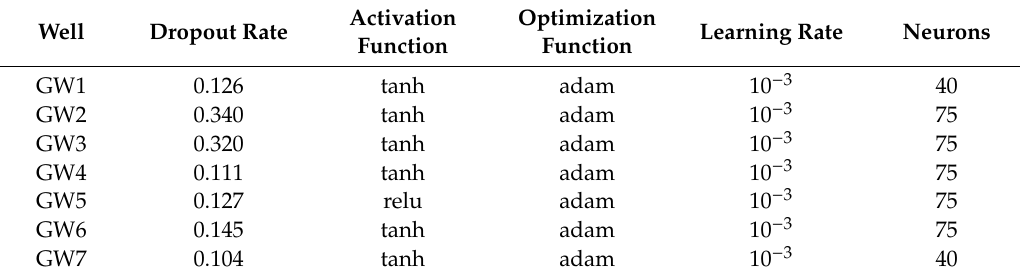
Table 8. Tuned hyperparameters for RNN models.